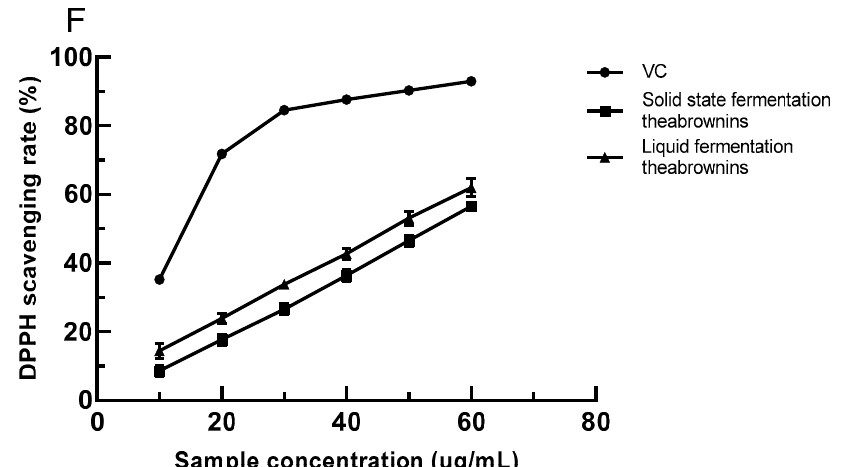
Figure 3. ( A ) The reducing power of VC concentration; ( B ) solid- and liquid-fermented theabrownins reducing power; ( C ) VC scavenging ability of hydroxyl radicals; ( D ) solid-state and liquid-fermented theabrownins scavenging ability of hydroxyl radicals; ( E ) the scavenging ability of VC and solid- and liquid-fermented theabrownins on superoxide anion free radicals; ( F ) the scavenging ability of VC, liquid-fermented, and solid-state fermented theabrownins by DPPH.